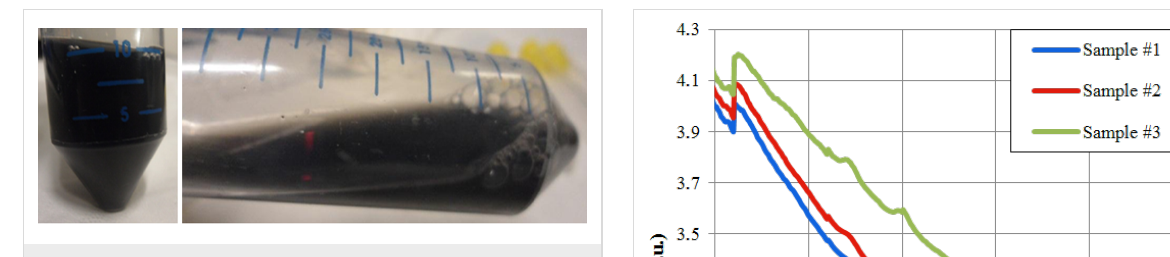
subjected to a continuous wave light source, were carried out.